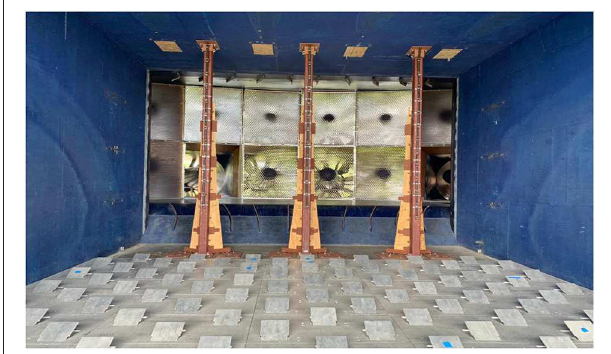
FIGURE 2 | Spires and floor roughness elements in the WOW flow management